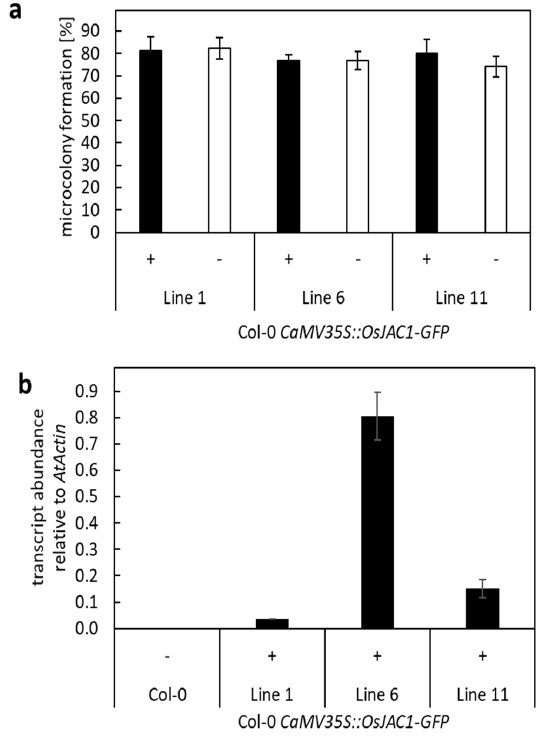
Figure 6. Transgenic Arabidopsis plants constitutively expressing OsJAC1-GFP . ( a ) Arabidopsis plants (Col-0) were transformed with CaMV35S::OsJAC1-GFP (Col-0 CaMV35S::OsJAC1-GFP ) using Agrobacterium tumefaciens -mediated transformation. Four rosette leaves from three to four plants of different T1 lines (line1, line 6, and line 11) were inoculated with G. orontii . Transgenic plants (+) and azygous sibling plants ( − ) from the same events were used. Microcolony formation of G. orontii on these plants were examined microscopically after 48 h p.i. and calculated as the rate of successful invasion related to the total number of attacked cells. The mean values are shown in percent with standard deviation. No statistically significant differences were determined using Student’s t-test ( P ≤ 0.96). ( b ) The transcript abundance of OsJAC1-GFP in plants of line 1, line 6, and line 11 was determined using qRT-PCR from the pooled RNA samples of four to five leaves and calculated relative to At Actin, according to Livak and Schmittgen (2001) [22]. The mean values from three technical replicates are shown with standard deviation.